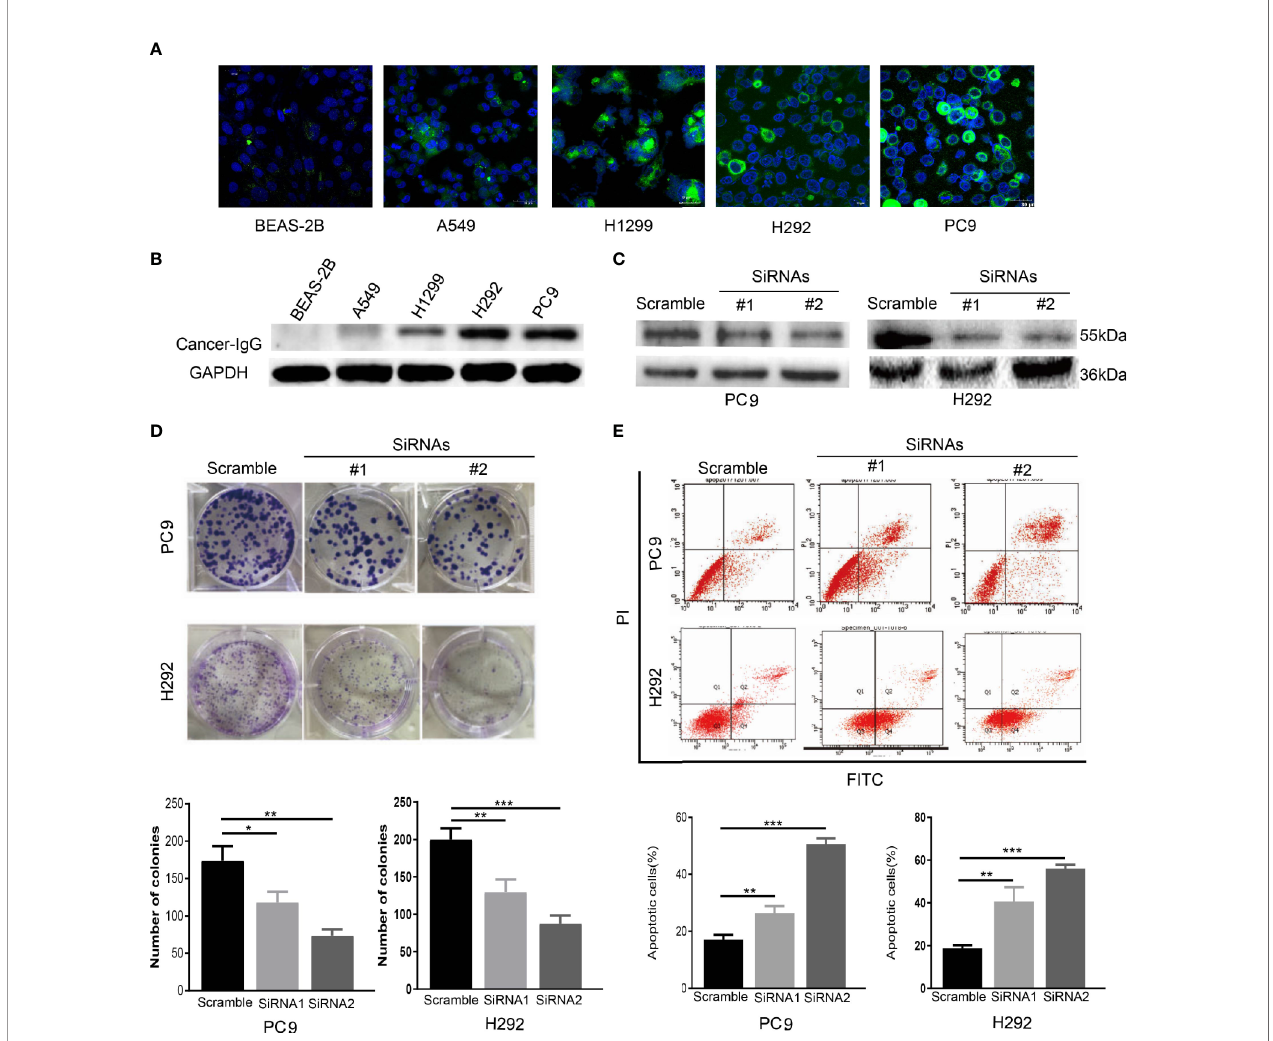
FIGURE 2 | The expression and function of cancer-IgG in LUAD cell lines and normal lung epithelial cells. (A, B) Immuno fl uorescence staining and western blot analysis are used to show cancer-IgG expression in a normal lung – derived cell line (BEAS-2B) and four LUAD cell lines (PC9, H292, H1299, A549). Scale bar, 30 m m. (C) Western blot is used for testing the ef fi ciency knockdown of cancer-IgG in PC9 and H292. (D) Plate cloning assay to evaluate the effect of silencing cancer- IgG on the proliferation of PC9 and H292 cells (n=3). (E) Flow cytometry assay to evaluate the effect of silencing cancer-IgG on the apoptotic ability of PC9 and H292 cells (n=3). * p < 0.05; ** p < 0.01; *** p <